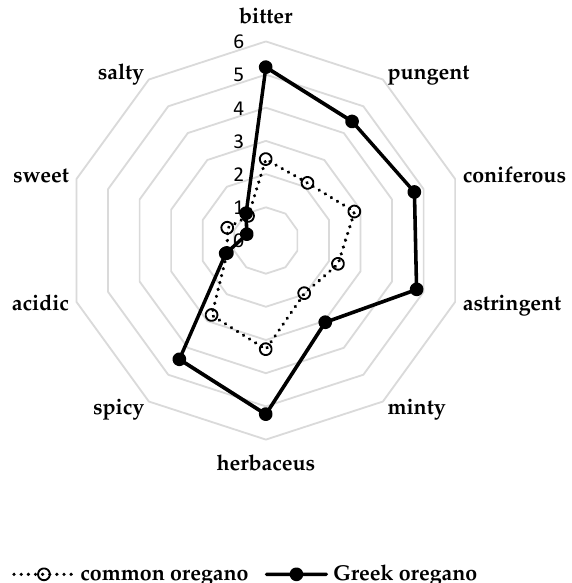
Figure 4. Sensory profile of herb taste of common oregano and Greek oregano.